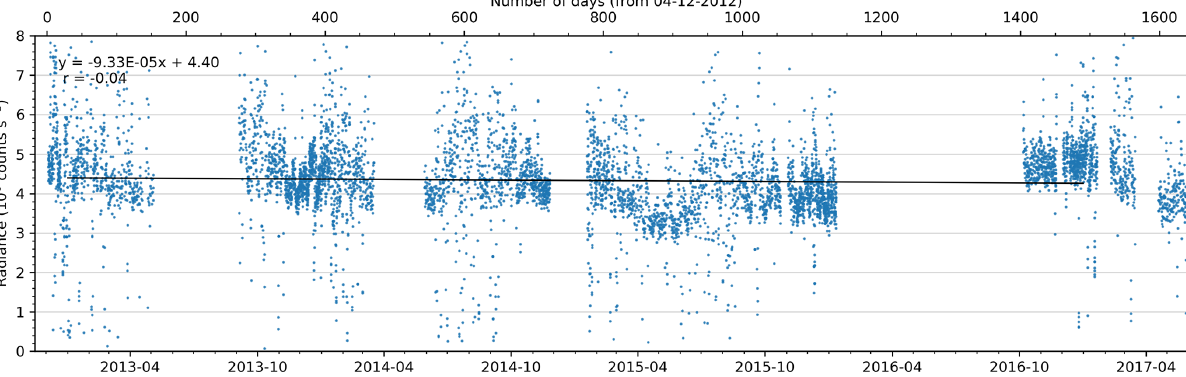
Figure B1. Time series of the measured radiances at 360nm derived from the MAX-DOAS measurements in the zenith viewing direction for SZA between 55 and 60 ◦ . Please note that the trend is calculated only for the measurements from 1 January 2013 to 31 December 2016 to minimize the effect of seasonal variation. The dark black line indicates the linear regression of the measured radiance as a function of day number.